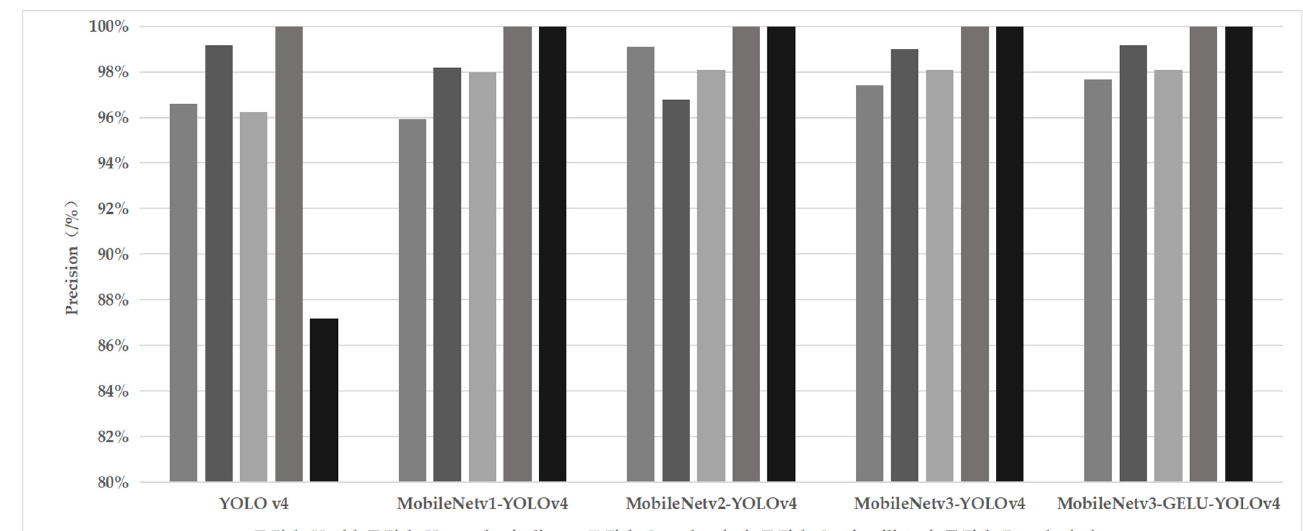
Figure 6. Fish skin disease detection effect on snubnose pompano with Hemorrhagic Septicemia ( a ) input; ( b ) YOLOv4; ( c ) MobileNet v1-YOLOv4; ( d ) MobileNet v2-YOLOv4; ( e ) MobileNet v3-